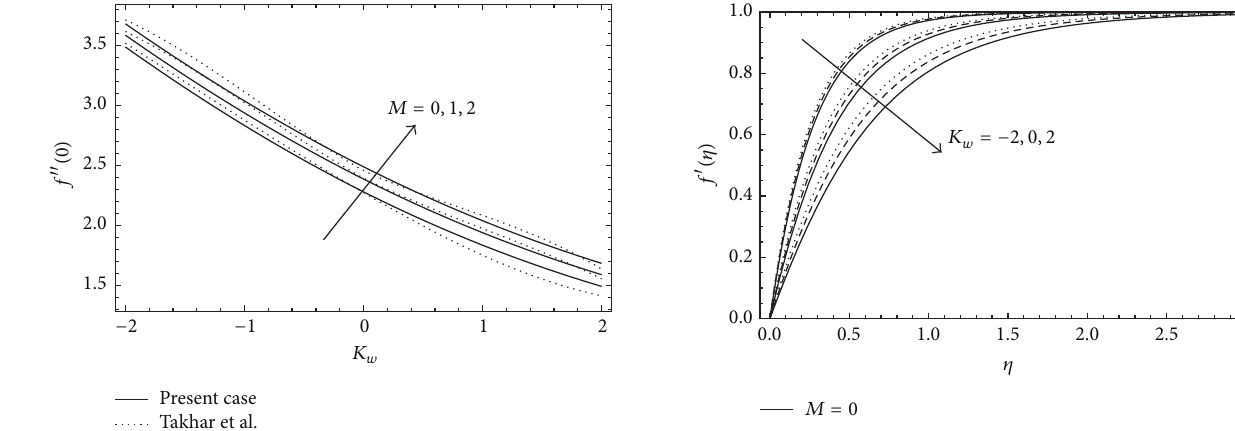
Figure 5: Variation of skin friction with 𝐾 𝑤 for 𝑀 = 0, 1,2 (cf. [4]).